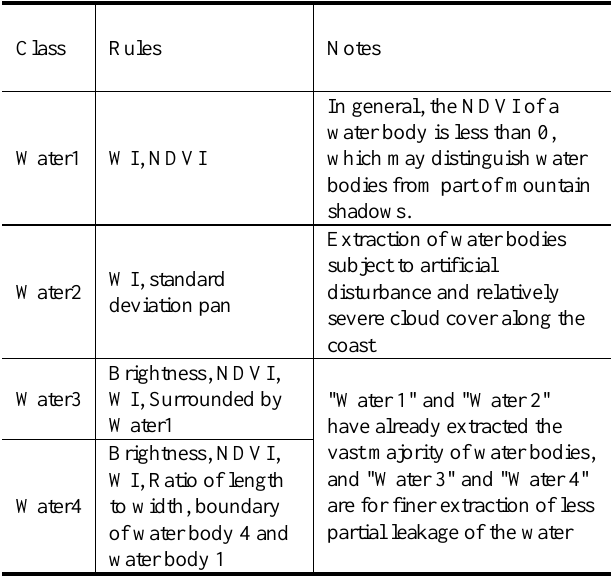
Figure 1. Road Extraction Features